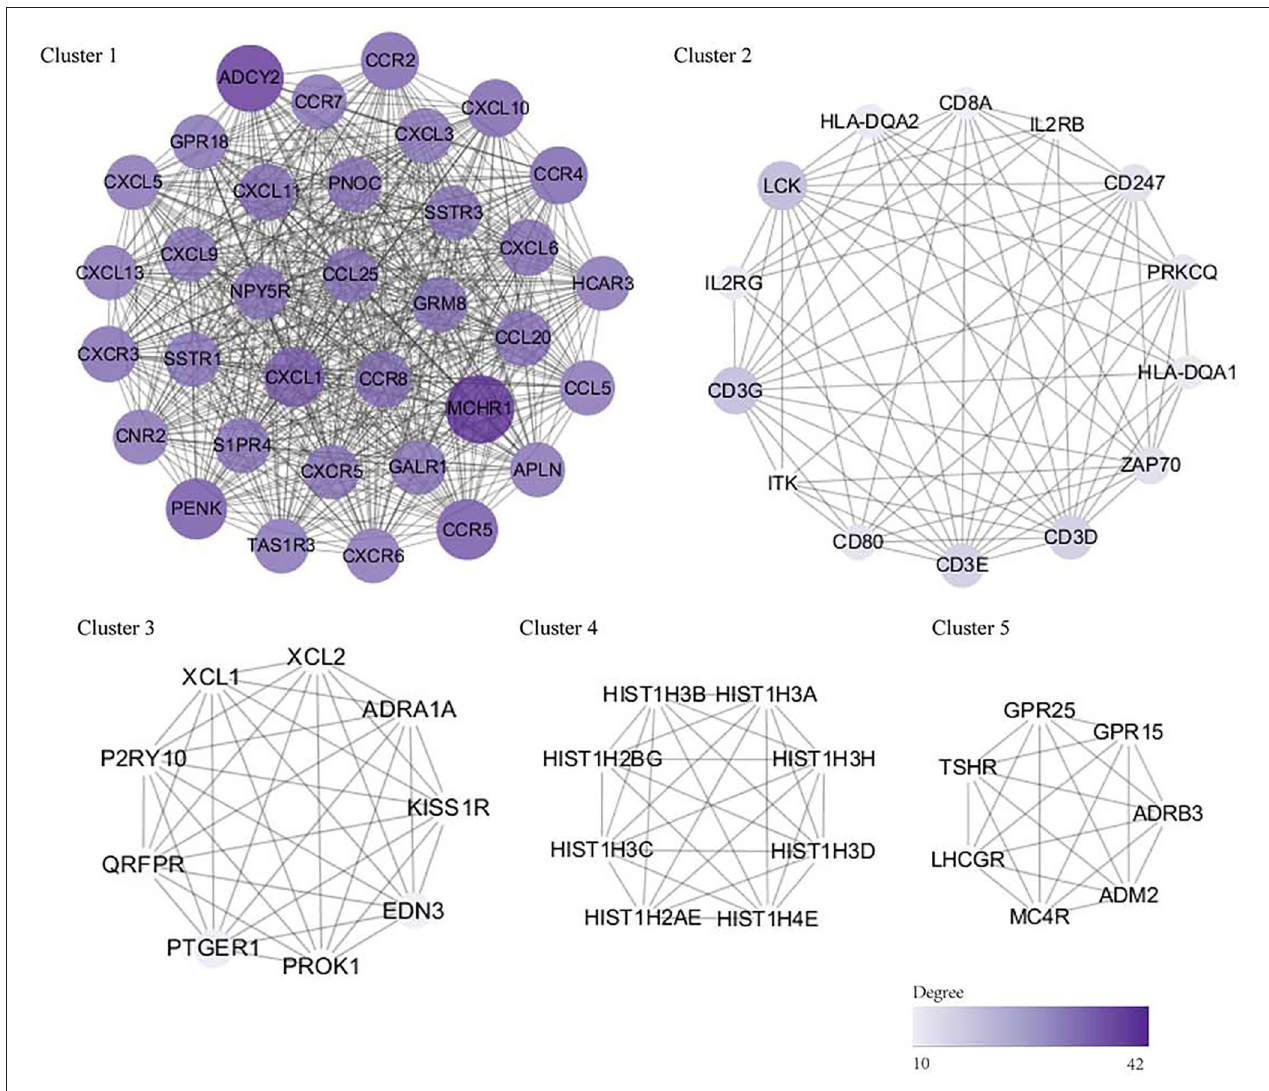
FIGURE 5 | The PPI network and hub genes (top five modules). The significant modules identified by the Molecular Complex Detection (MCODE) and the cytoHubba plugin of Cytoscape. The size and color of circles represent the degree of the hub gene. The darker the color, the bigger the circle, and the higher the degree of the core gene. DEG, differentially expressed gene; PPI, protein–protein